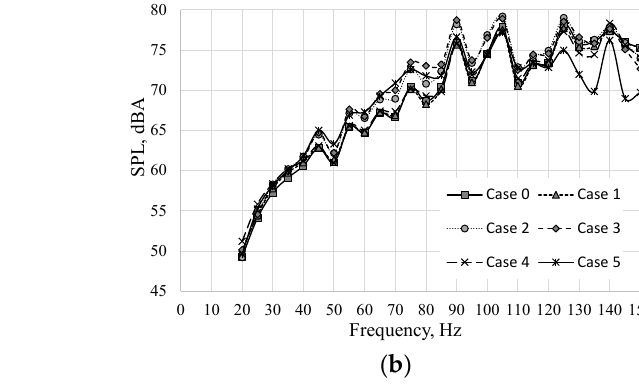
Figure 3. SPL vs. frequency: ( a ) Case 0 at the different real power; ( b ) different cases at the real power P = 4 W.